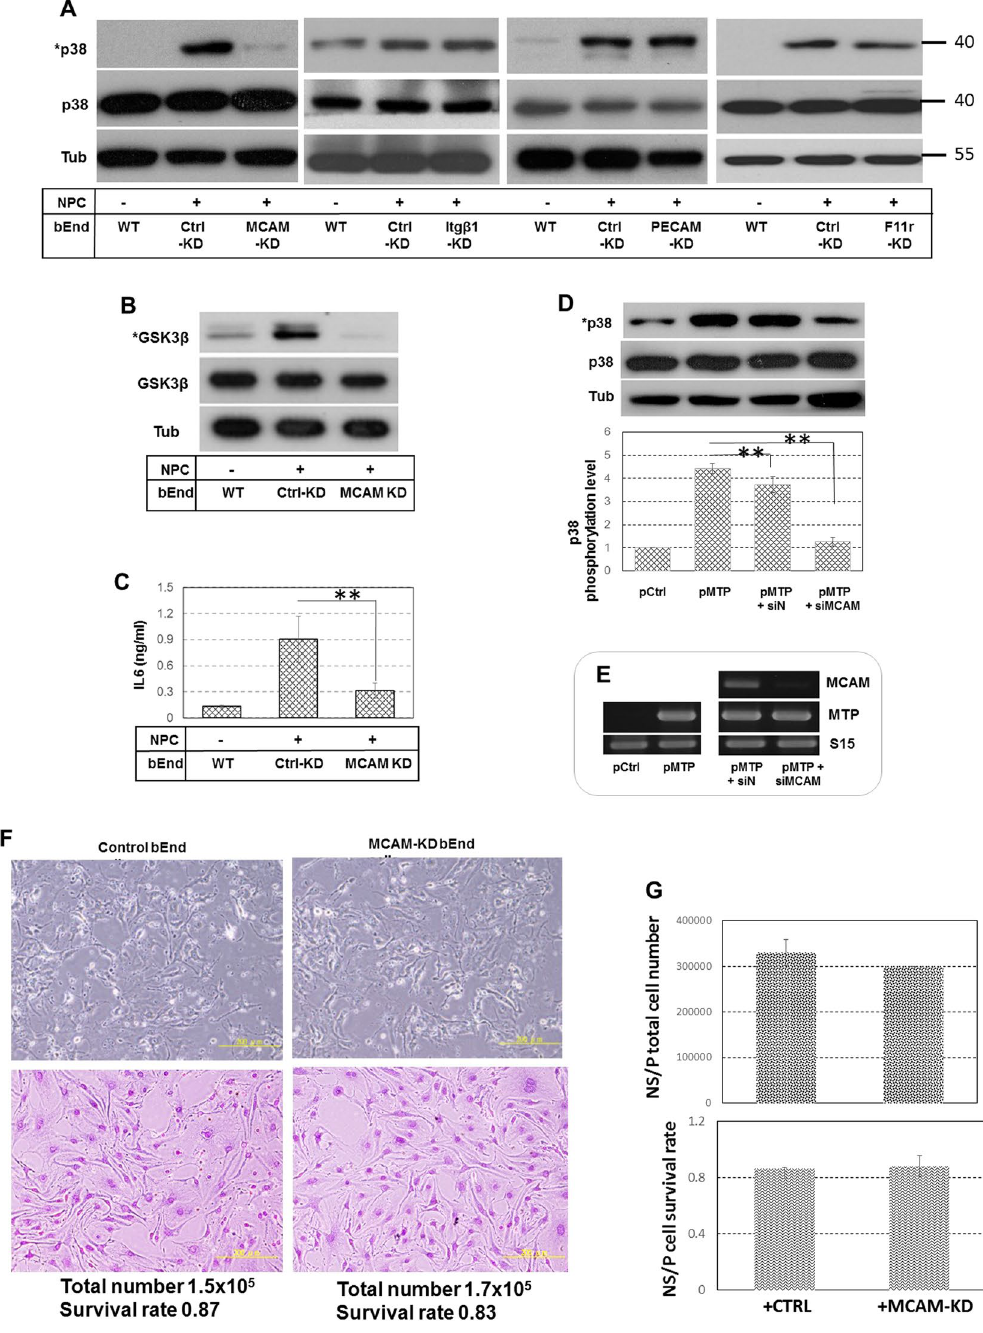
Figure 4. Presence of both MTP and MCAM are essential for NS/P cells and bEnd cells contact interaction. ( A ) Western blot of endothelial p38MAPK. Total p38MAPK (p38) and phosphorylated p38MAPK ( * p38) were examined in wild-type bEnd cells (WT), control siRNA transfected bEnd cells (Ctrl-KD), MCAM knockdown bEnd cells (MCAM KD), integrin β 1 knockdown bEnd cells (itg β 1-KD), PECAM knockdown bEnd cells (PECAM-KD) or F11r knockdown bEnd cells (F11r-KD) cultured alone or in contact co-culture with NS/P cells ( − or + NPC, respectively). The same results were observed in three independent experiments. ( B ) Western blot of endothelial GSK3 β . GSK3 β serine 9 phosphorylation ( * GSK3 β ) and total GSK3 β protein in wild-type (WT), control siRNA transfected (Ctrl-KD) or MCAM knockdown (MCAM KD) bEnd cells cultured alone or in contact co-culture with NS/P cells ( − or + NPC, respectively). ( C ) ELISA of endothelial IL6 in the medium of wild-type (WT), control siRNA transfected (Ctrl-KD) or MCAM knockdown (MCAM KD) bEnd cells cultured alone or in contact co-culture with NS/P cells ( − or + NPC, respectively). Data were collected from three independent experiments. ( D ) Western of p38MAPK in bEnd cells transfected with an empty expression plasmid (pCtrl), with the MTP expression plasmid (pMTP), with the MTP expression plasmid plus a control siRNA (pM + siN), or with the MTP expression plasmid plus MCAM-specific siRNA (pM + siMCAM). ( E ) RT-PCR of MCAM and MTP from cells used in the experiments in “D”. ( F ) Representative images of